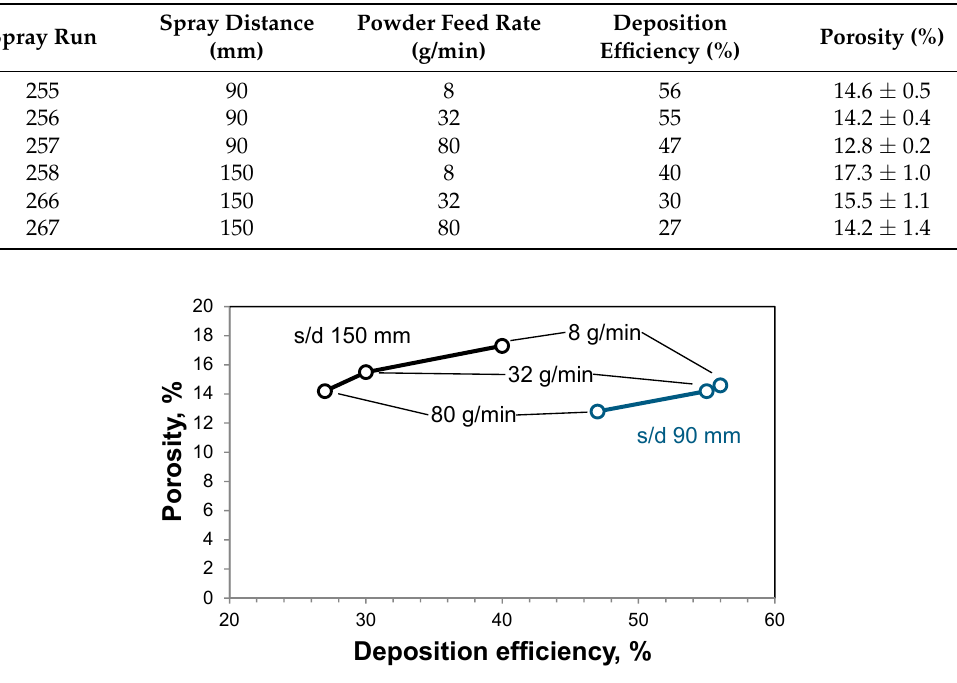
Figure 4. Deposition efficiencies and coating porosities for different spray distances and powder feed rates (TriplexPro™-210 at low power with Ar–He plasma gas mixture, powder 321 M); porosities averaged from three images.